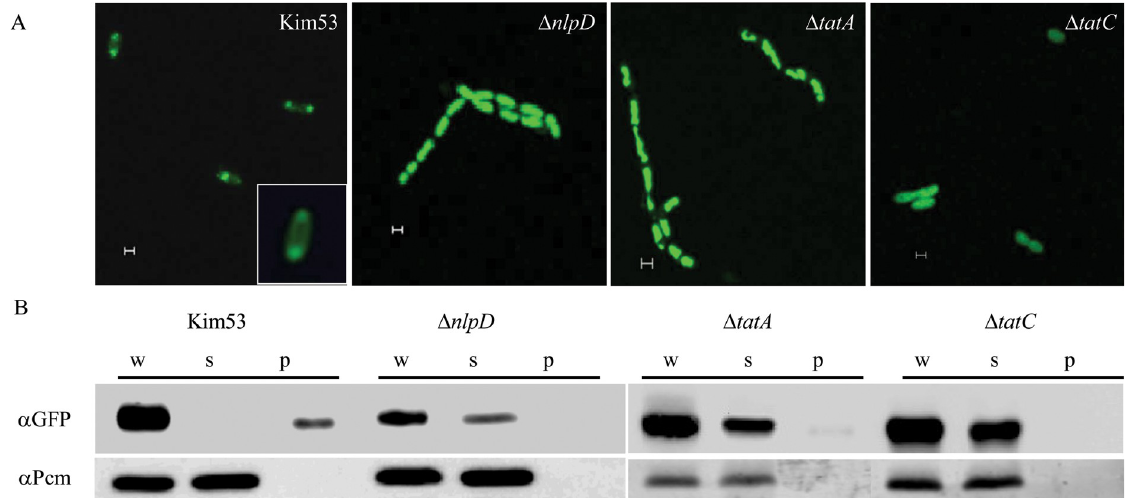
Fig 2. Intracellular localization of the TorA signal -GFP Tat-reporter protein in Y . pestis strains. A. Y . pestis strains Kim53:pTorA signal - GFP, Kim53 Δ nlpD :pTorA signal -GFP Kim53 Δ tatA :pTorA signal -GFP, and Kim53 Δ tatC :pTorA signal -GFP, were inspected under a fluorescence microscope for identification of TorA signal -GFP localization. The scale bar represents 1 μ m. B. Y . pestis cells overproducing TorA signal -GFP were fractionated into Whole cell (W), spheroplast (S) and periplasm (P), and were subject to immunoblotting with antibodies against GFP or against the cytoplasmic protein Pcm [20]. The blots were derived from the same experiment and were processed in parallel. The data presented are representative of at least two independent experiments and the displayed data is one representative experiment.